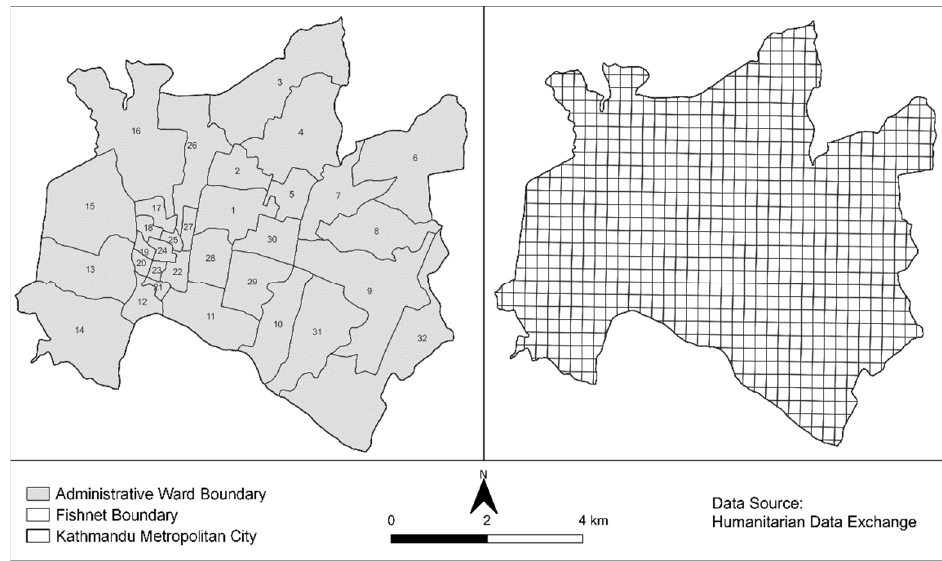
Figure 2. Administrative Ward-level (left) VS 0.0025° Fishnet-level (Right) division of Kathmandu Metropolitan City.